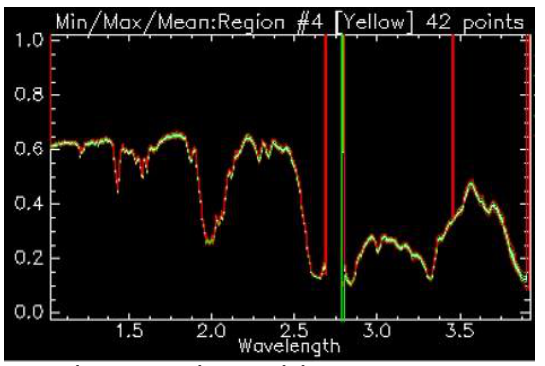
Figure 8: Maximum, minimum mean and standard deviations for the ROI in yellow in figure 7